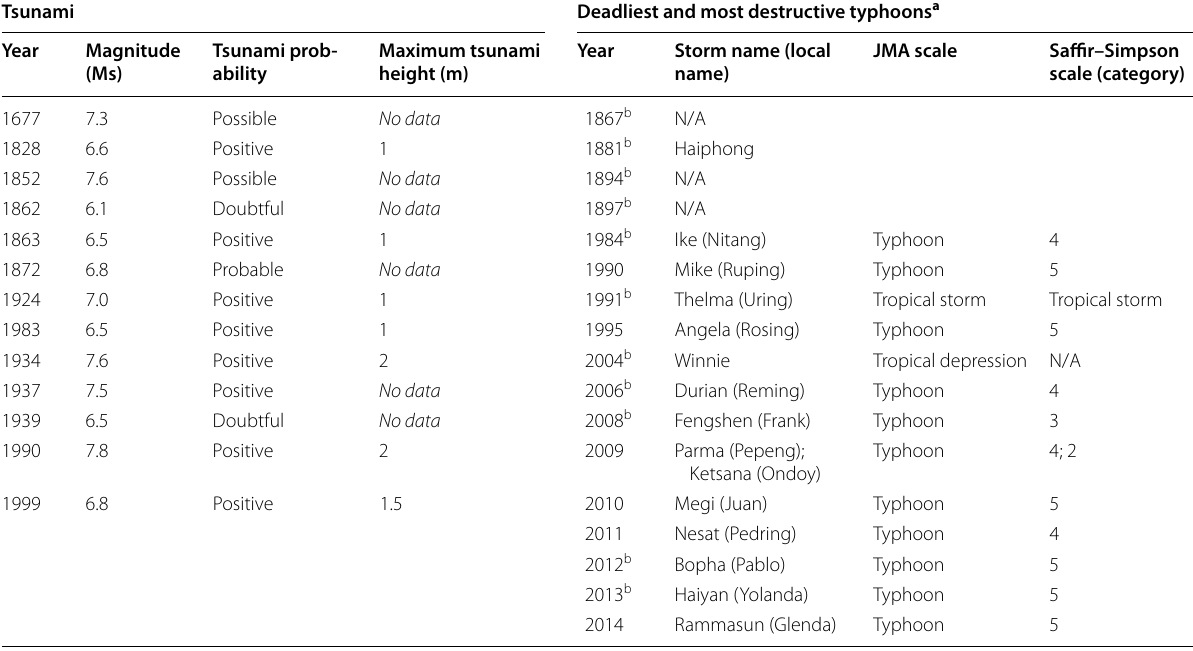
Table 4 Historical extreme wave events in west